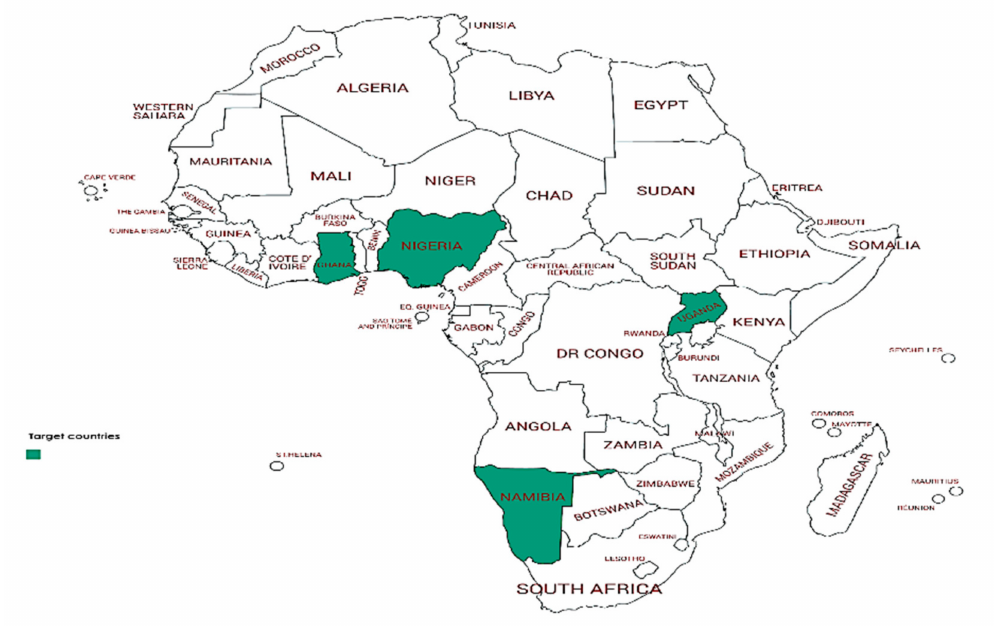
Figure 2. Target countries: Ghana, Nigeria, Namibia, and Uganda are shown in green in the map of